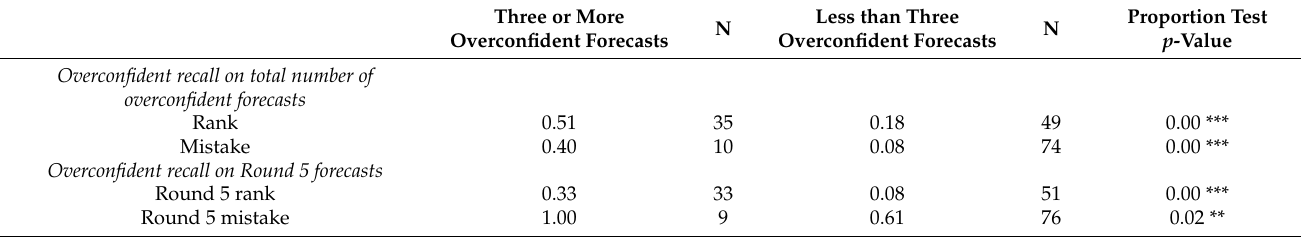
Table 4. Comparison of Overconfident Recall Conditional on Overconfidence in Forecasts.